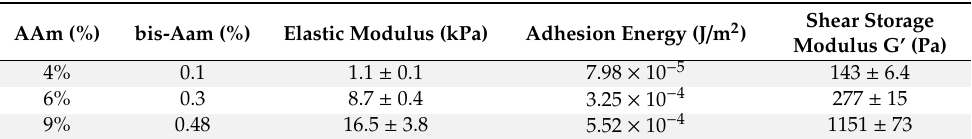
Table 5. Monomer and crosslinker concentration of three PAAm hydrogels, their corresponding elastic modulus and adhesion energy, measured by colloidal probe AFM indentation upon a load of 10 nN and an indentation rate of 2 µ m / s. The shear storage modulus was measured with a rotational rheometer with a parallel plate geometry (DHR-3, TA instruments) as a function of frequency at a constant strain of